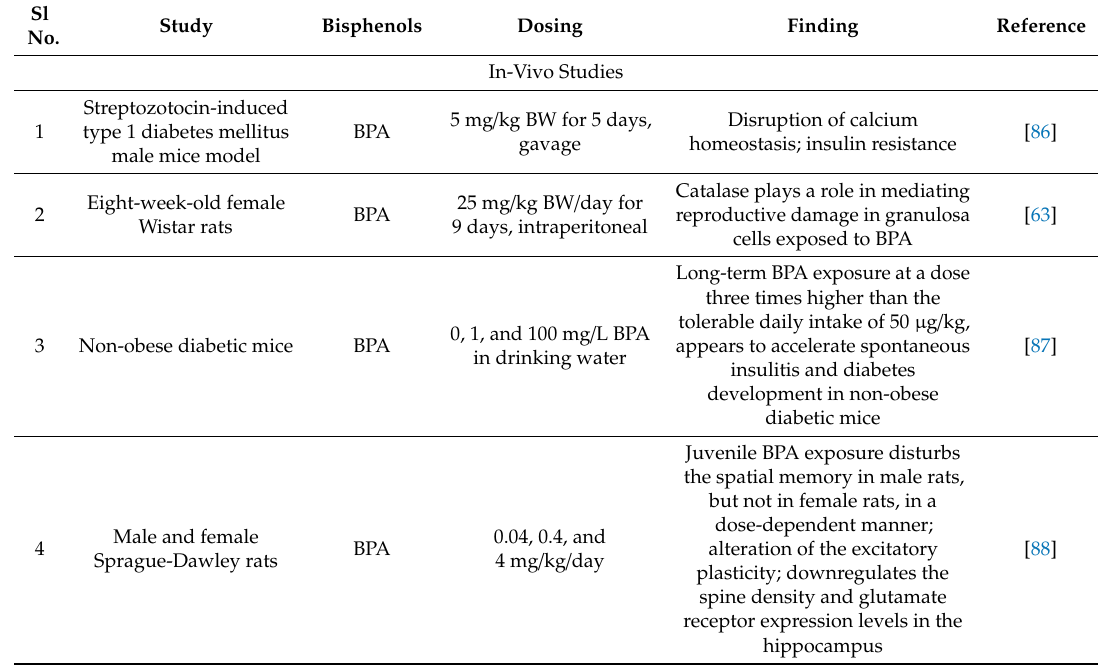
Table 3. E ff ect of Bisphenol exposure in di ff erent experimental